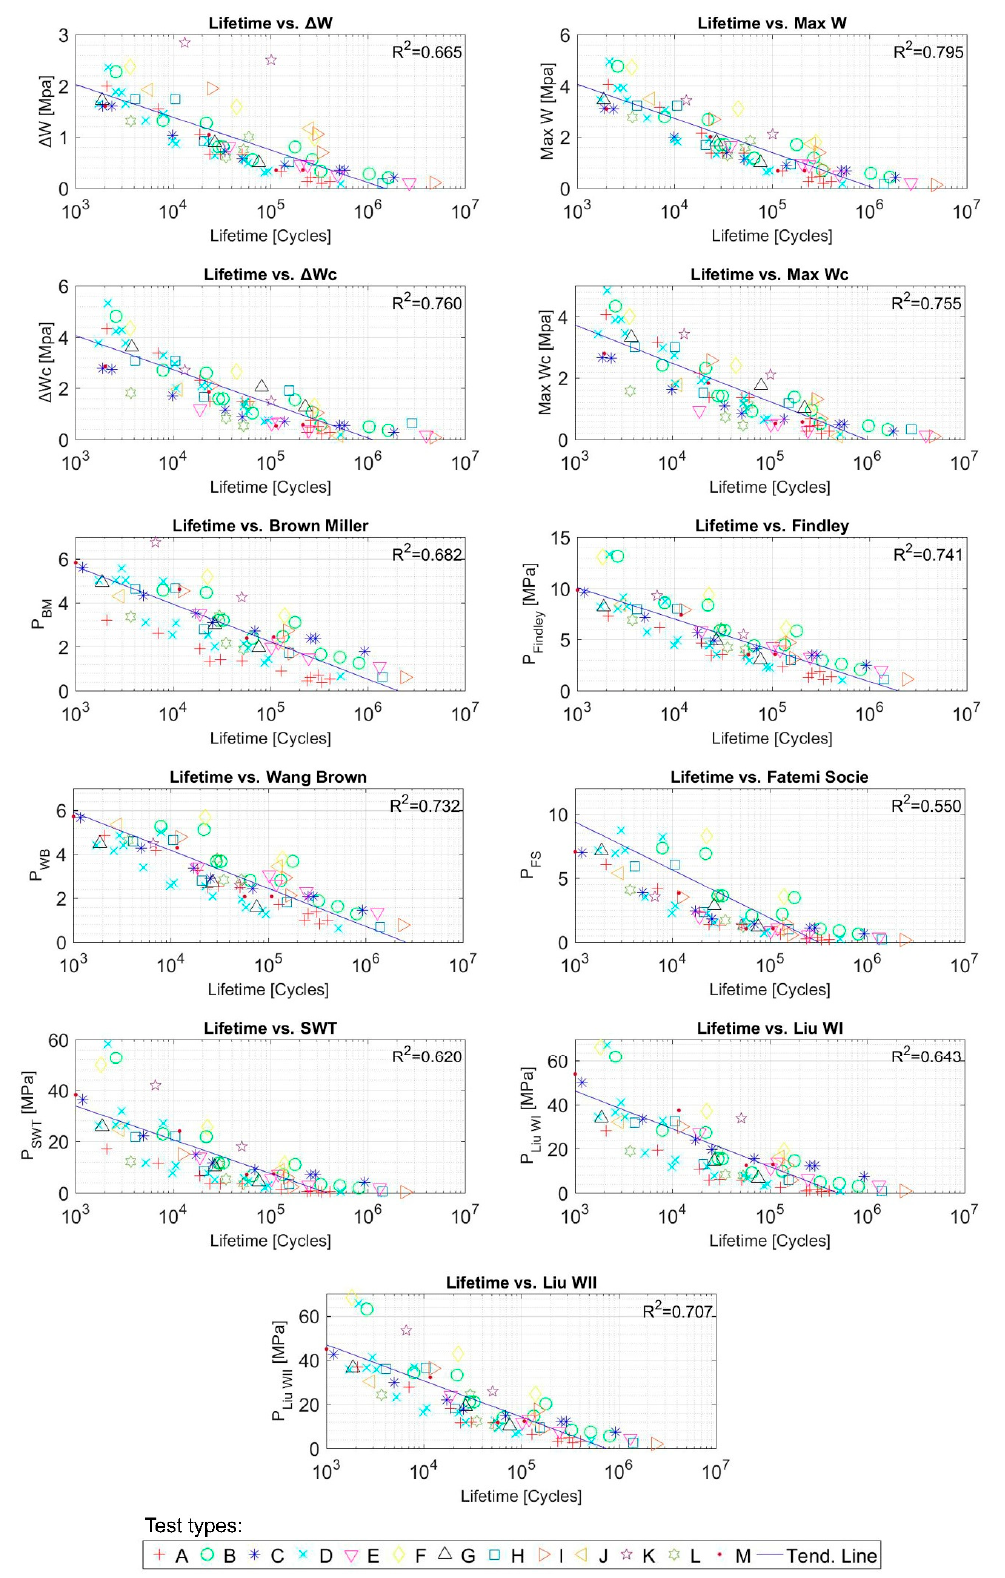
Figure 10. Fatigue parameters and tests lifetime [cycles] correlation for NBR tests. Initial data from